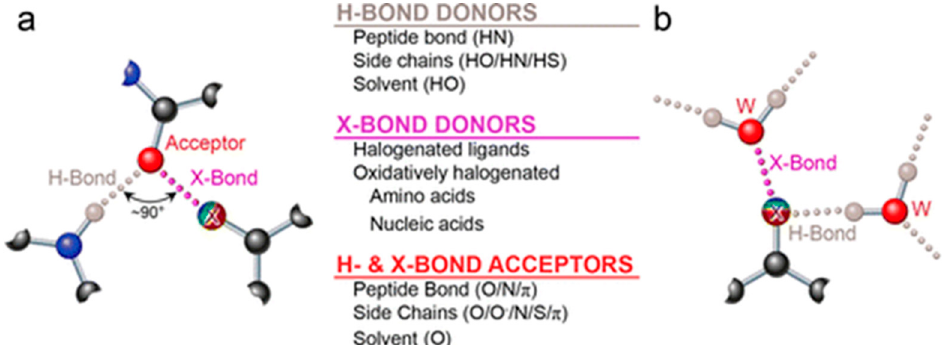
Figure 6. The versatility of halogens and additionally non-halogen Lewis bases in chemical bonding. ( a ) A Lewis-base acceptor (red, Oxygen) can make halogen bonding interactions with the sigma-hole end of a halogen atom (x; bluish to red indicates electrostatic potential trend from +ve to –ve) while simultaneously proffering other lone pairs for H-bonding; ( b ) A halogen atom involved in both X-bonding via its sigma hole and H-bonding via its lone pairs). Both interactions show are with water molecules (figure has been reproduced from